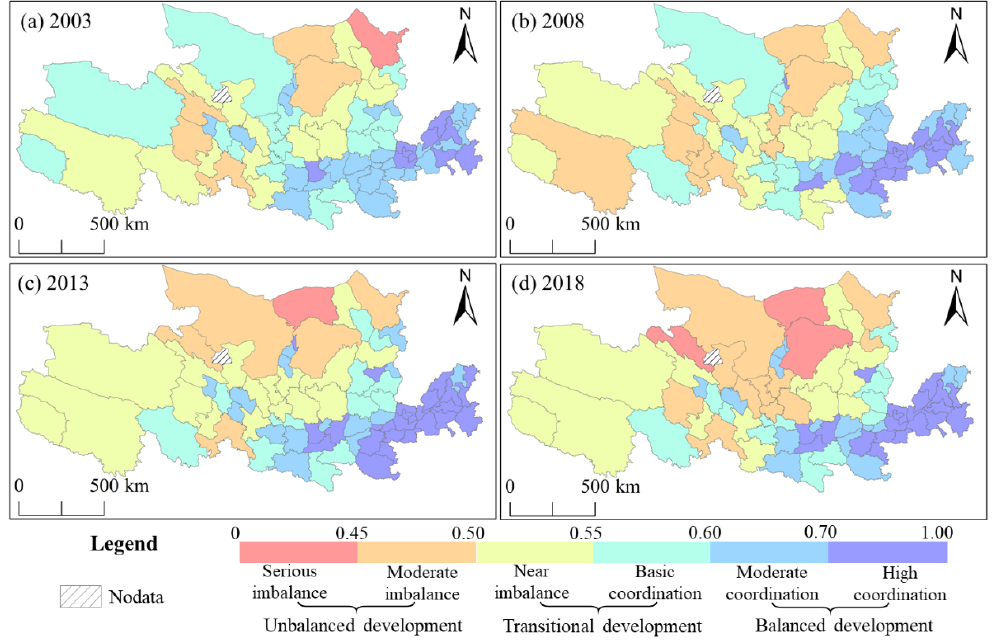
Figure 5. Level of coupling coordination between RLUT and FS in the YRB. a, b, c and d denote the coupling coordination level between RLUT and FS in 2003, 2008, 2013 and 2018, respectively.